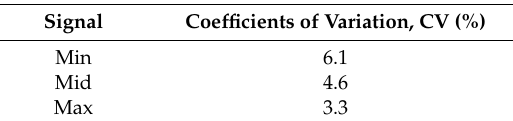
Table 1. Well-to-well reproducibility of viral protein 24 (VP24) inhibition assay.